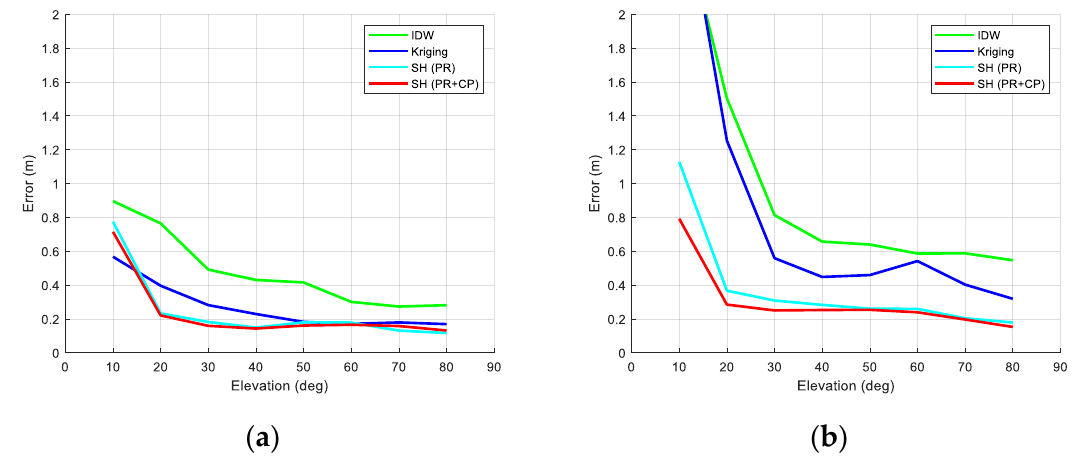
Figure 15. Residual error according to the elevation angle (real data, 12 September 2014): ( a ) Users 1 and 5; ( b ) Users 2 – 4.